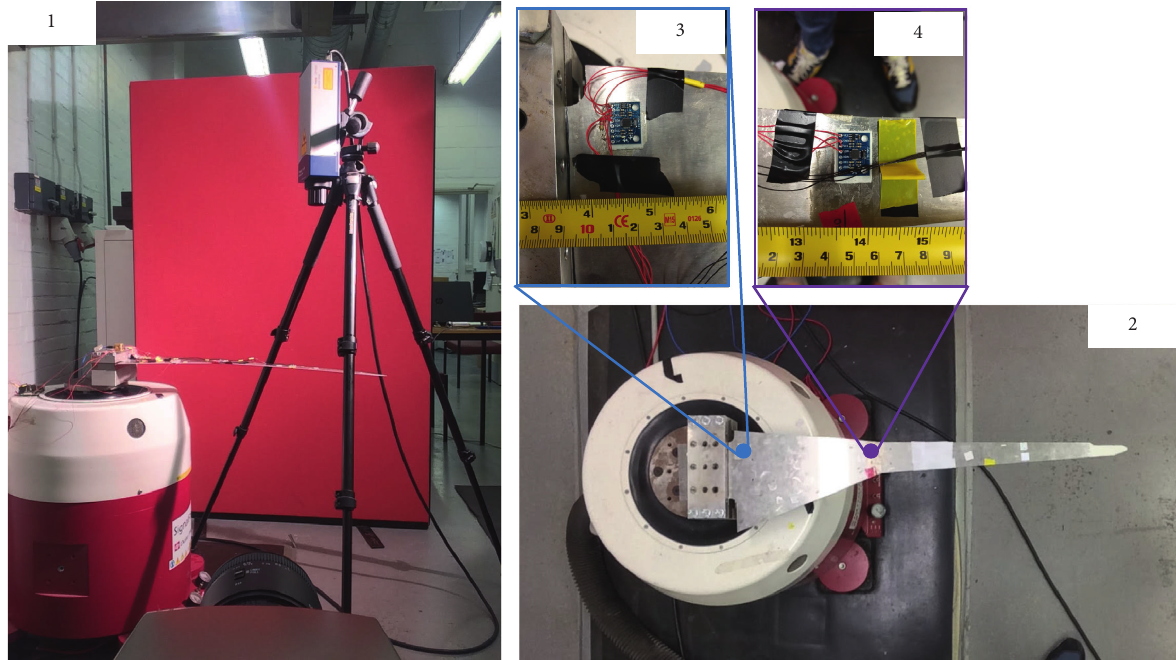
Figure 2: The first experimental setup (prototype wing spar, Cranfield University). (1) Point of view from the high-speed video camera; (2) upper view of the spar without sensors attached; (3)-(4) the IMU